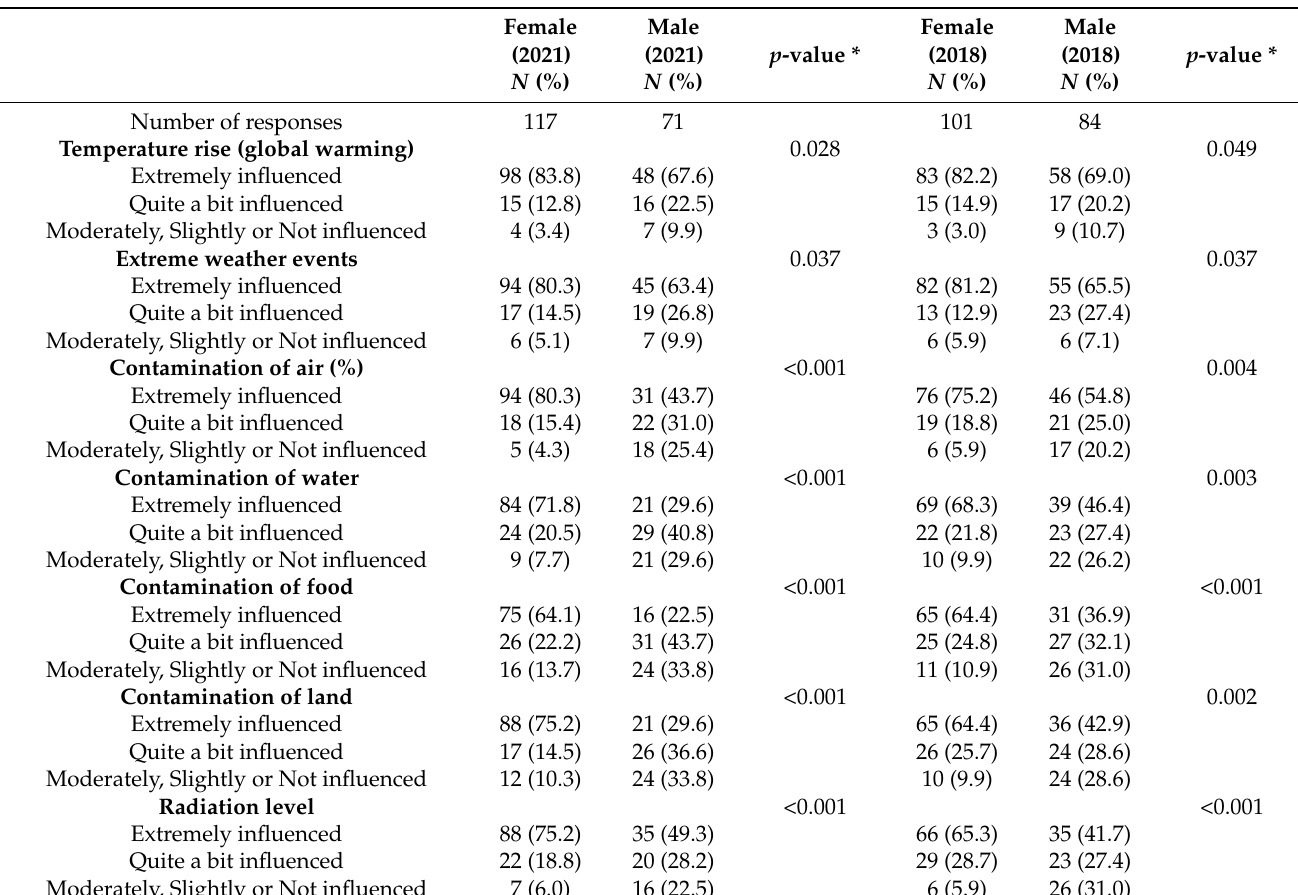
Table 4. Perceived influence level of environmental factors by climate change, by sex, to the 2018 and 2021 survey question: “To what degree do you think that the following factors are being influenced by climate